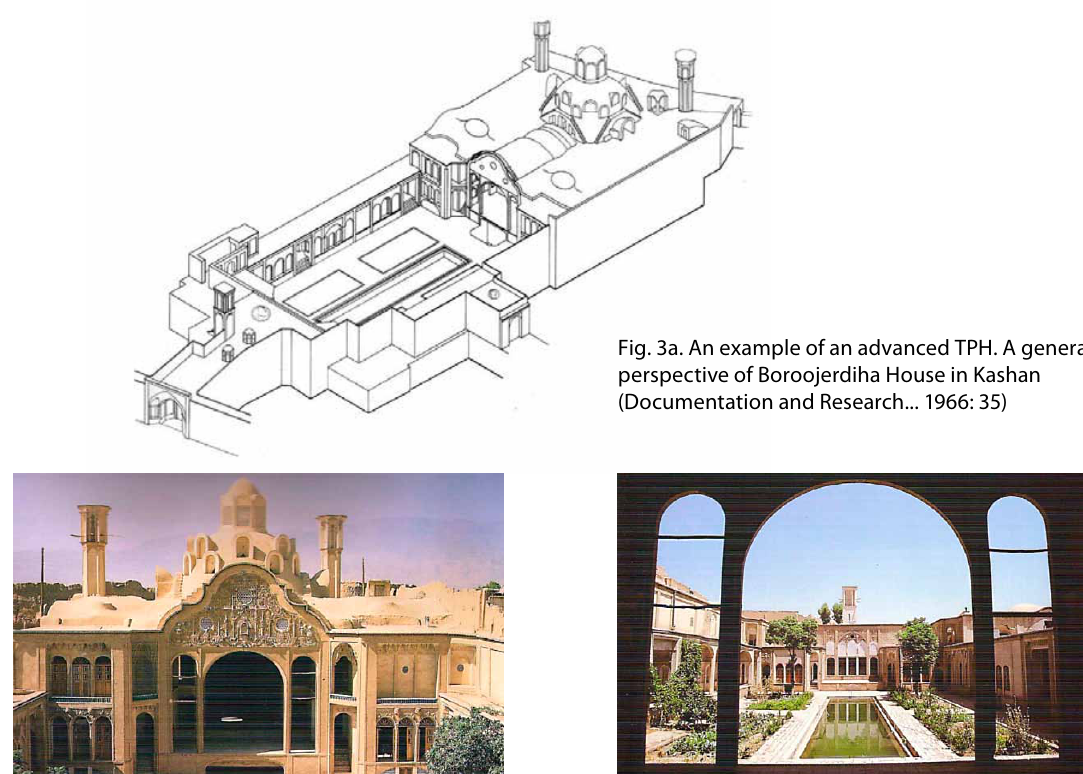
fig. 3b. façade of the southern ‘Eivan’ of Boroojerdiha House ( Ibid ., p. 35)